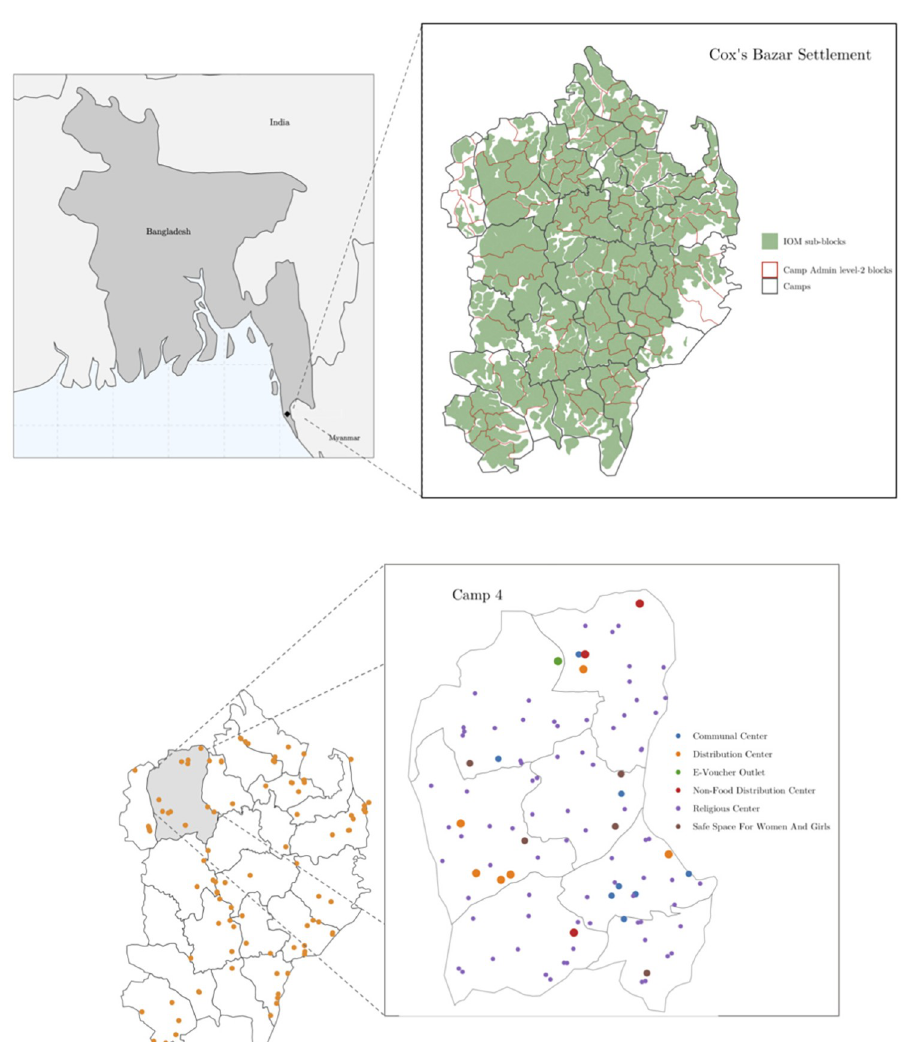
Fig 1. Digital twin geographic and location information. Upper left: Map of Bangladesh showing location of the Cox’s Bazar settlement. Upper right: Map of the modelled expansion site with three geographical layers. Lower left: modeled distribution centers. Lower right: Detailed view of Camp 4 showing six types of modeled locations. Basemaps from [22, 23].